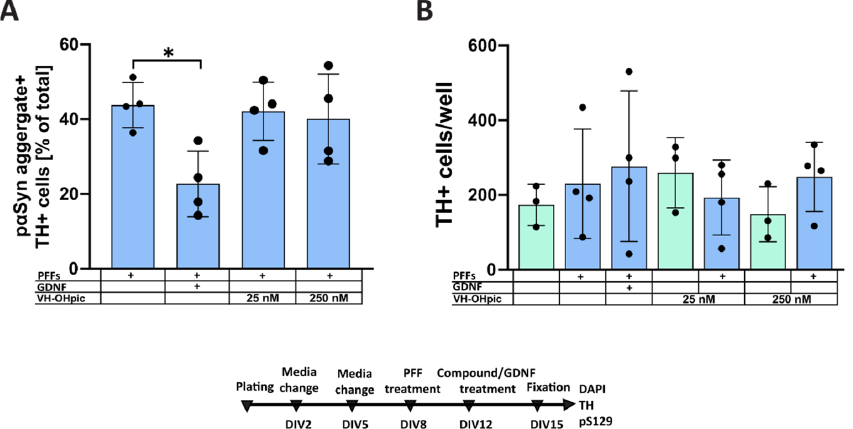
Figure 3. Effect of PTEN inhibitor VO-OHpic on the accumulation of p α Syn in midbrain dopaminergic neurons. Enhancing insulin signaling with PTEN inhibitor VO-OHpic had no significant effect on the accumulation of p α Syn in midbrain dopaminergic neurons. ( A ) Quantification of p α Syn-positive accumulations within TH-positive dopaminergic neurons. GDNF added to the cells on DIV12, the same day as a compound, significantly reduced the aggregations of intracellular p α Syn, while VO-OHpic showed no significant effect. ( B ) Quantification of TH-positive cells per well. n = 3–4 independent experiments, data are mean ± SD, * p < 0.05.